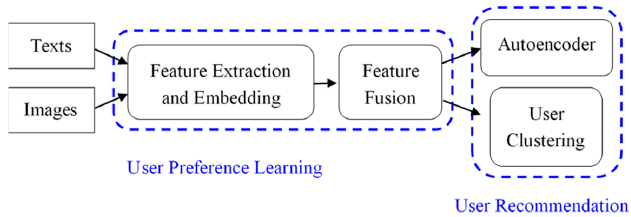
Figure 1. The system architecture of our proposed method.